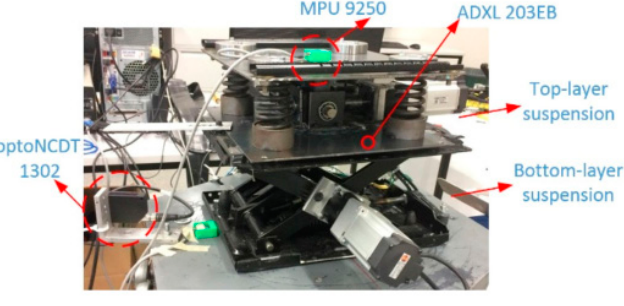
Figure 17. Multiple-DOF seat suspension prototype [53].